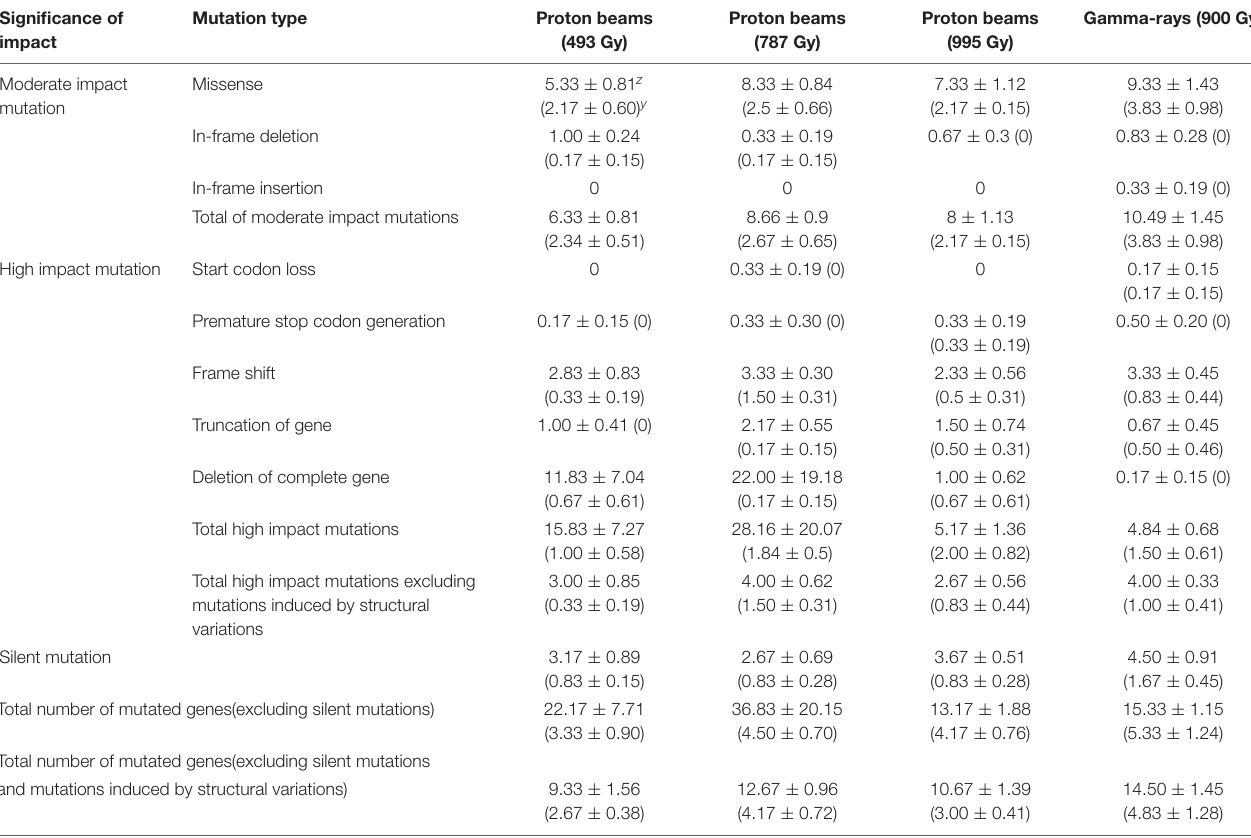
TABLE 4 | Number of genes affected by DNA mutations induced by proton beams and gamma-rays. Significance of